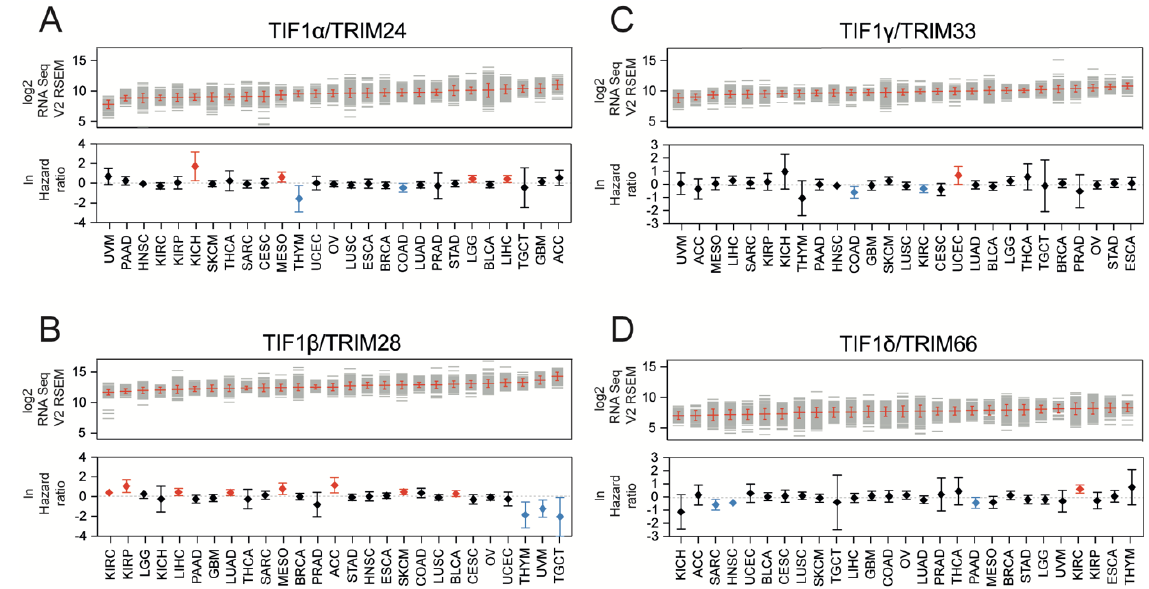
Figure 1. The expression of Transcriptional Intermediary Factor 1 (TIF1) family members across distinct solid tumor types. The expression of ( A ) Tripartite Motif protein 24 (TRIM24), ( B ) TRIM28, ( C ) TRIM33, and ( D ) TRIM66 in 27 solid tumor types based on RNA Seq RSEM V2 data from The Cancer Genome Atlas database (TCGA) (top panel). Each grey line represents a single tumor sample. The mean value and standard deviation (SD) within tumor type are marked with red. The bottom panel presents the hazard ratio (lnHR) of death for patients with high expression of specific TIF1 family members (with the mean as a cut-off). Red and blue denotes statistically significantly higher or lower hazard ratios, respectively. The HRs for individual tumor types are given with 95% confidence intervals (CIs). Tumor types: ACC—adrenocortical carcinoma; BLCA—bladder urothelial carcinoma; BRCA—breast invasive carcinoma; CESC—cervical squamous cell carcinoma and endocervical adenocarcinoma; COAD—colorectal adenocarcinoma; ESCA—esophageal carcinoma; GBM—glioblastoma multiforme; HNSC—head and neck squamous cell carcinoma; KICH—kidney chromophobe; KIRC—kidney renal clear cell carcinoma; KIRP—kidney renal papillary cell carcinoma; LGG—brain lower grade glioma; LIHC—liver hepatocellular carcinoma; LUAD—lung adenocarcinoma; LUSC—lung squamous cell carcinoma; MESO—mesothelioma; OV—ovarian serous cystadenocarcinoma; PAAD—pancreatic adenocarcinoma; PRAD—prostate adenocarcinoma; SARC—sarcoma; SKCM—skin cutaneous melanoma; STAD—stomach adenocarcinoma; TGCT—testicular germ cell tumor;